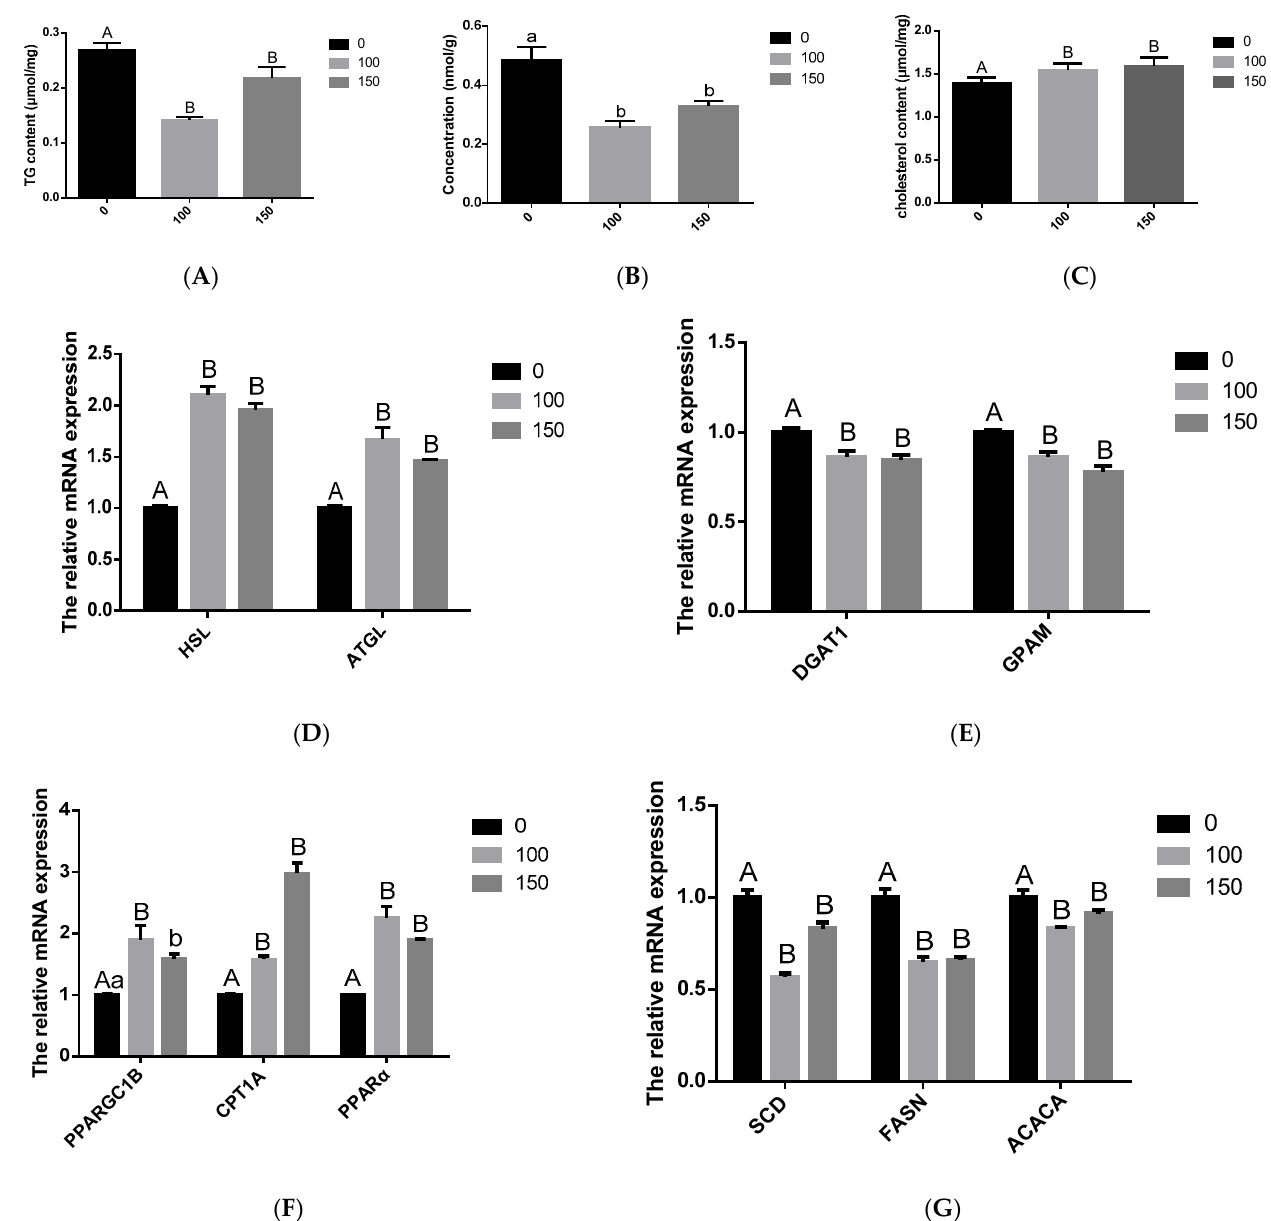
Figure 2. Effect of Chitosan oligosaccharide (COS) on milk fat synthesis of bovine mammary epithelial cells (BMECs). The levels of triglyceride (TG) ( A ), non-esterified fatty acids (NFFA) ( B ) and cholesterol ( C ) in BMECs treated with COS (0, 100, 150 μ g/mL) for 24 h were measured. Further, verify that COS inhibits milk fat synthesis. The mRNA expression of HSL and patatin like phospholipase domain containing 2 ( ATGL ) related to triglyceride decomposition ( D ); the mRNA expression of genes diacylglycerol O-acyltransferase 1 ( DGAT1 ) and glycerol-3-phosphate acyltransferase ( GPAM ) related to triglyceride synthesis ( E ); the mRNA expression of genes PPARG coactivator 1 beta ( PPARGC1B ), carnitine palmitoyltransferase 1A ( CPT1A ) and PPAR α related to triglyceride decomposition ( F ); the mRNA expression of genes SCD1 , FASN and acetyl-CoA carboxylase alpha ( ACACA ) related to free fatty acid synthesis ( G ). The data are presented as the mean ± SEM ( n = 3). Different small letters showed significant difference ( p < 0.05), different capital letters showed extremely significant difference ( p < 0.01), and the same letters or unmarked letters had no significant difference.